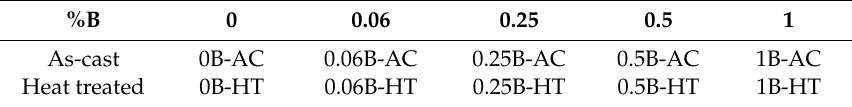
Table 2. Identification of materials.